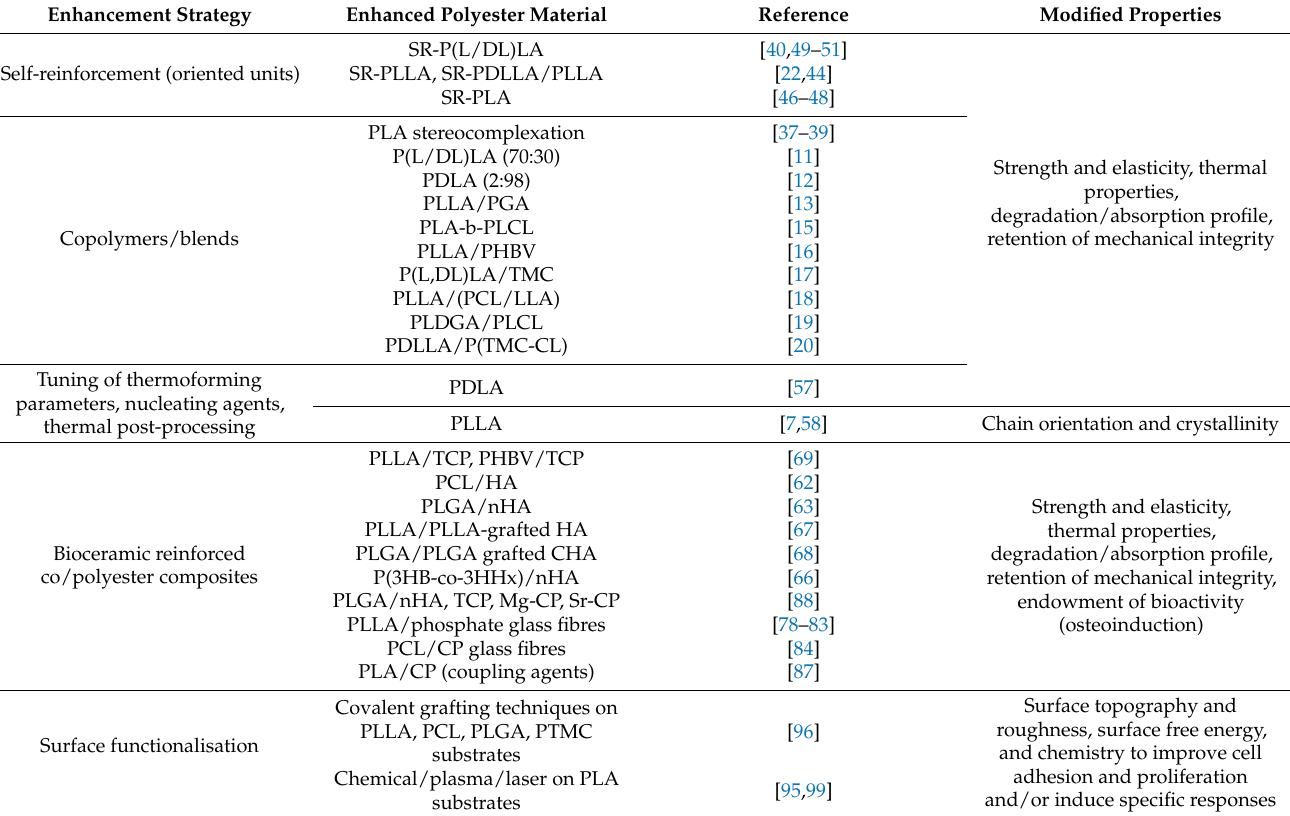
Table 4. Polyester enhancement strategies for bone fixation bioresorbable polyester